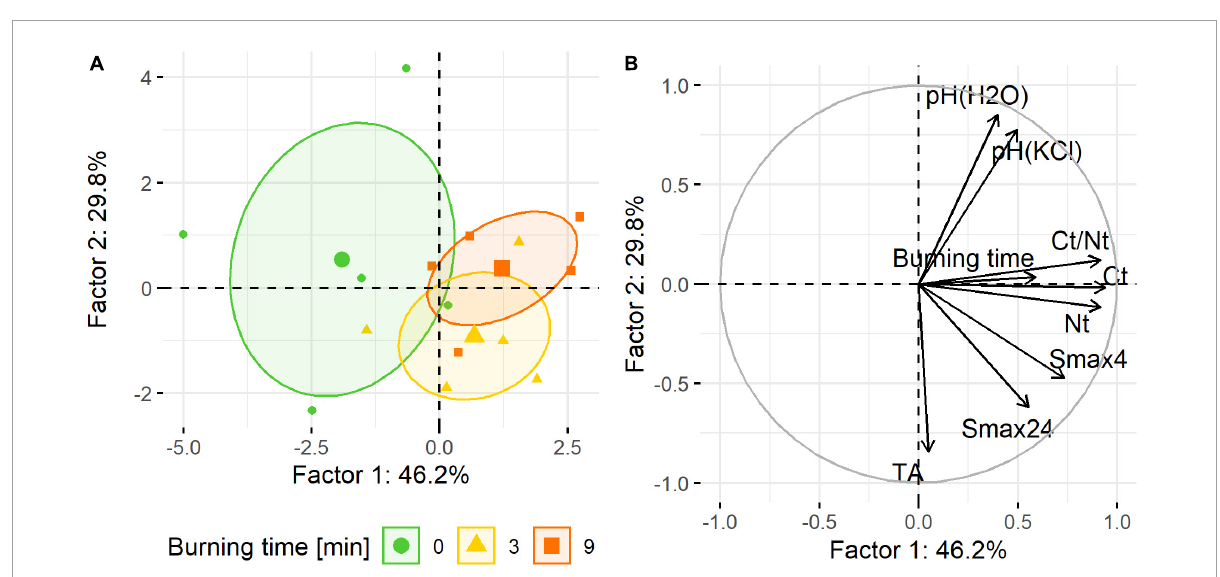
FIGURE4 Plot of individuals (PCA) (A) and principal component analysis (B) for the physicochemical properties of soil samples subjected to burning.